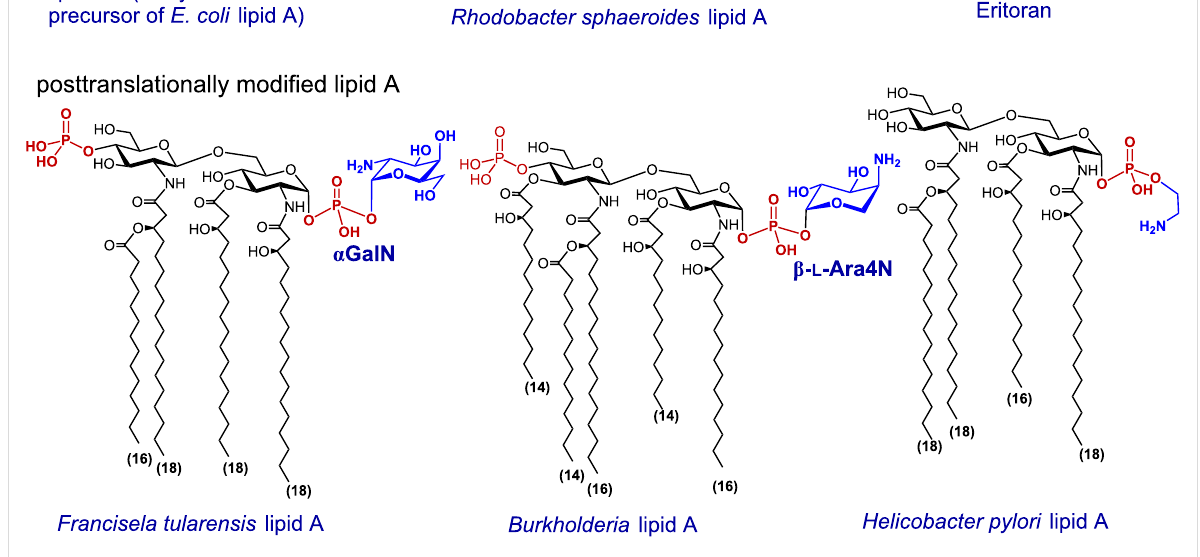
pathology [55]. Therapeutic down-regulation of the TLR4 signaling is believed to be beneficial for treatment of numerous chronic and acute inflammatory diseases such as asthma [51], arthritis [52], influenza [50], and cancer [56].